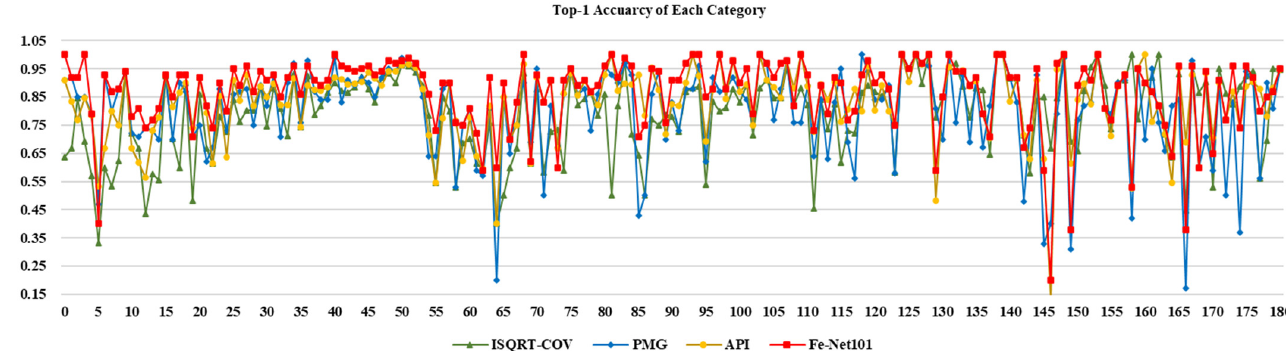
Figure 11. Identification accuracy results of Fe ‐ Net for each category.